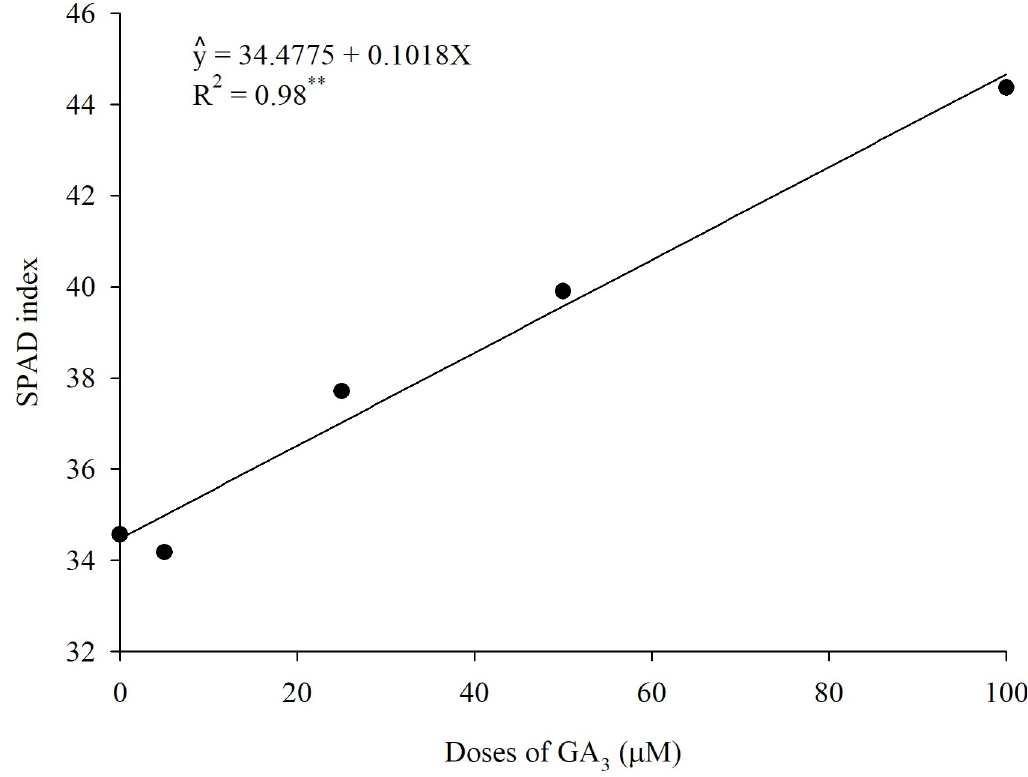
Fig 6. SPAD index as a function of different doses of GA 3 (1st cycle).